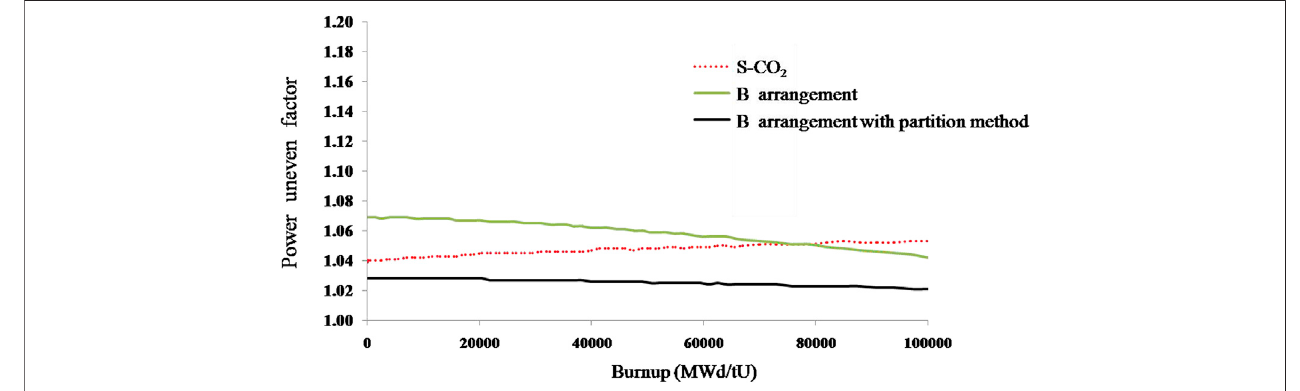
FIGURE 13 | Power uneven factor by arrangement B with the partitioning